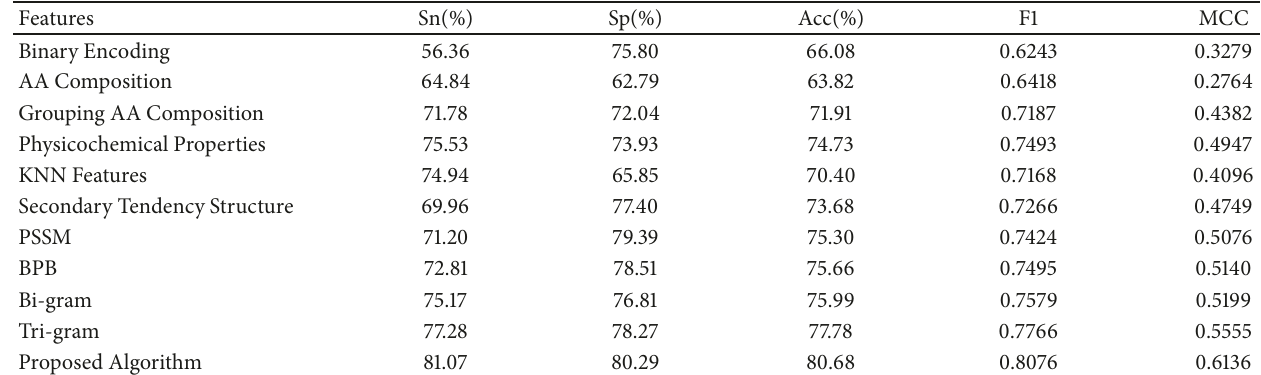
Table 1: The Performances of Different Features.